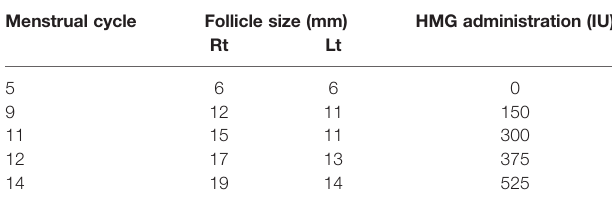
TABLE 2 | Transition in follicular development during OI.